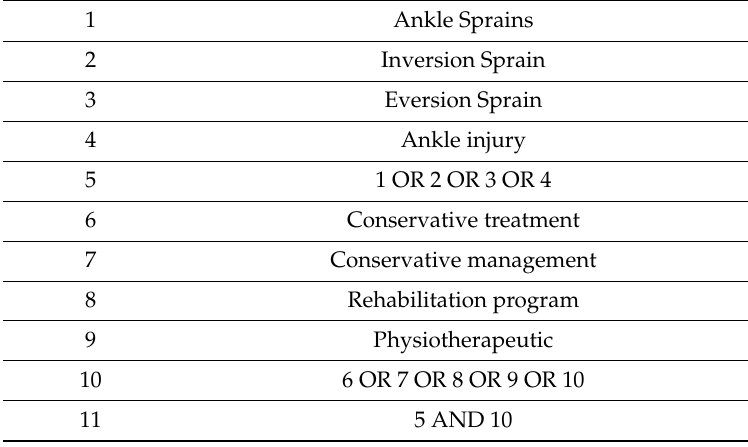
Table A4. SPORTSDiscus via EBSCOHost. Total articles: 5618.